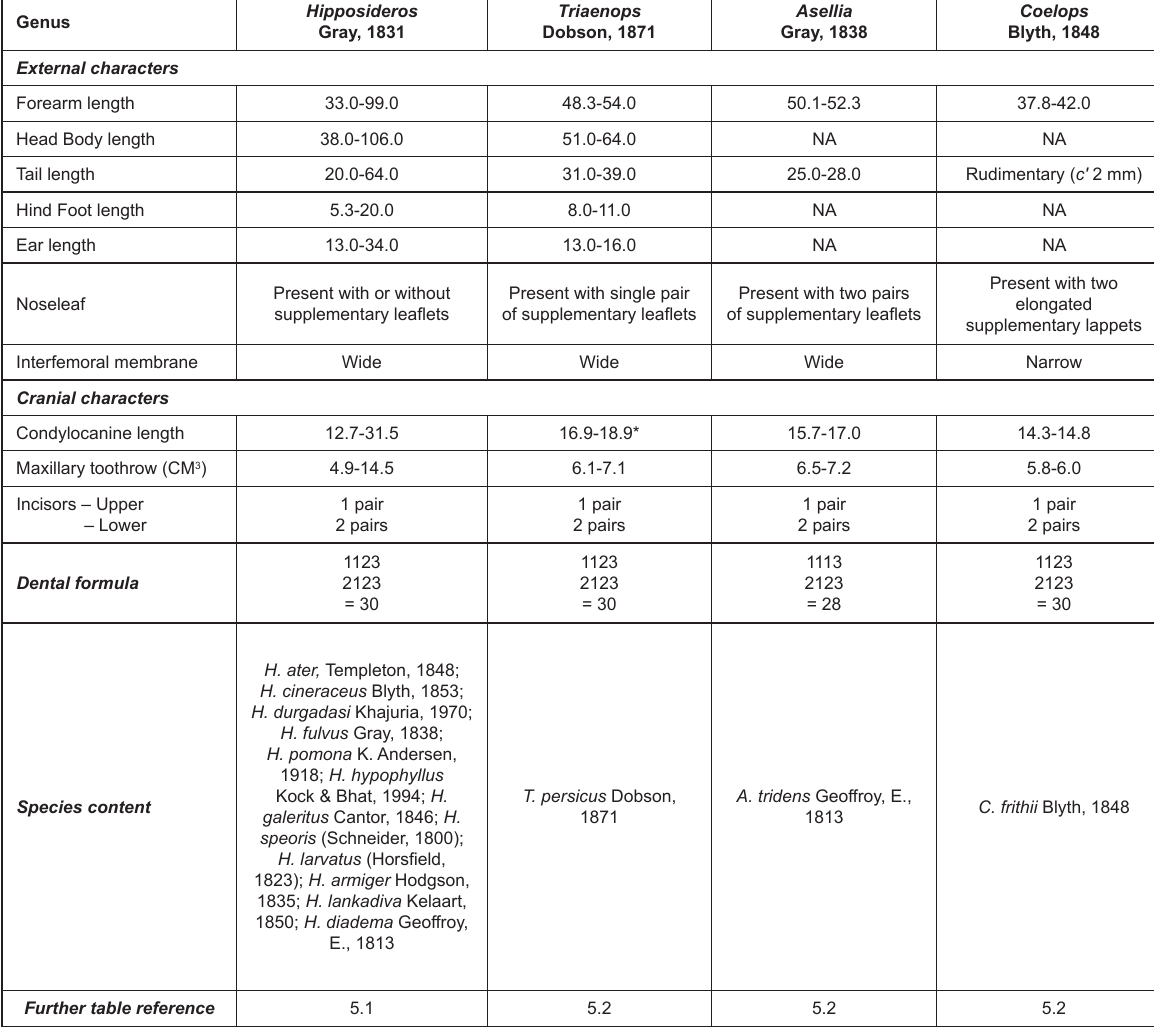
Table 5. Diagnostic morphological characters of the genera of the family hipposideridae present in South